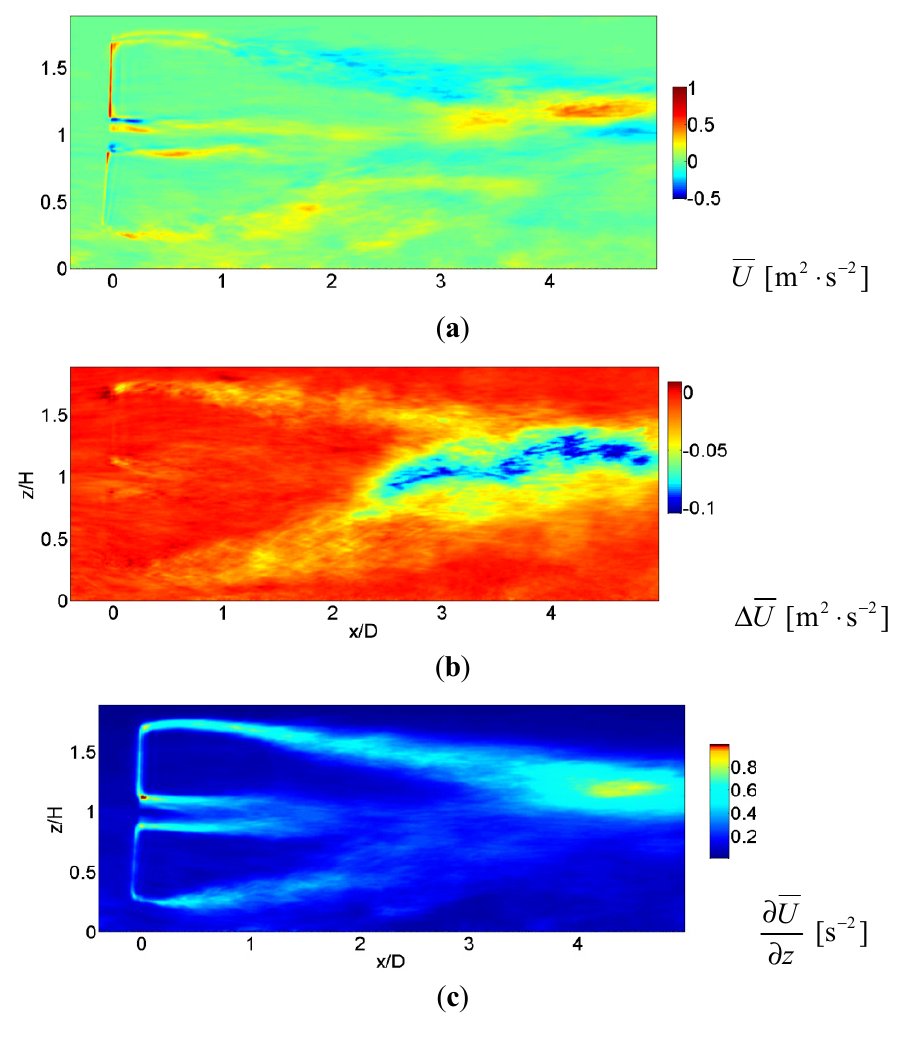
Figure 6. Contours of ( a ) time-averaged streamwise velocity; ( b ) deficit of time-averaged streamwise velocity; ( c ) mean wind shear at center plane, y/D = 0 in low-stable ABL